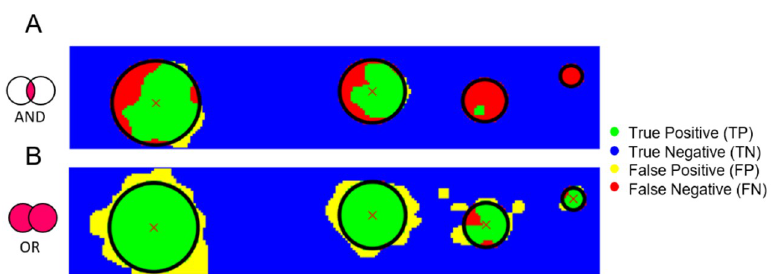
Figure 8. Classification (TP–TN–FP–FN) for all the points of the indentation matrix following the AND ( A ) and OR ( B ) logics of stiffness‐ and ultrasound‐based classifications shown in Figure 7.